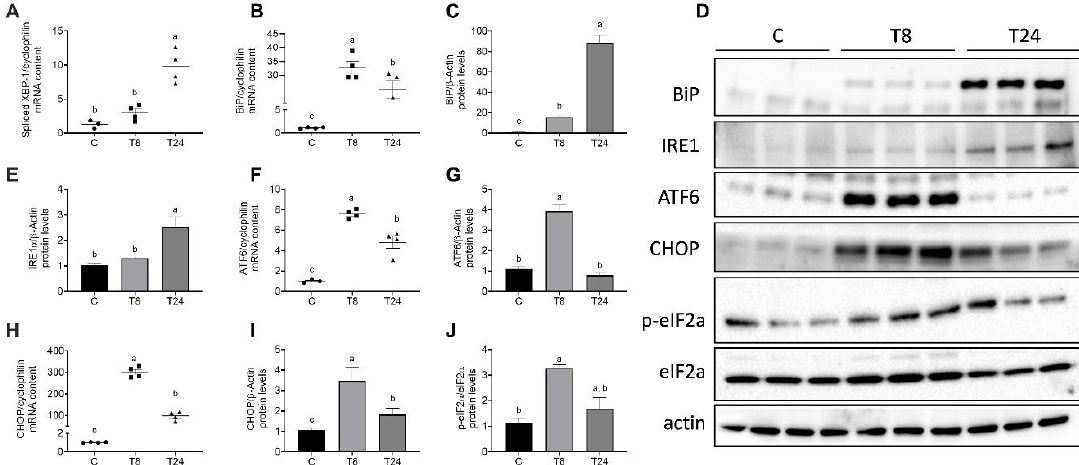
Figure 4. Activation of the unfolded protein response (UPR) in the kidney of mice treated with tunicamycin. Mice received a single i.p. injection of vehicle or tunicamycin (1 g/Kg body weight), and the kidney was obtained after 8 h (T8) or 24 h (T24). Spliced XBP-1 ( A ) and BiP mRNA content ( B ), densitometric analysis of BiP protein content ( C ), BiP, IRE-1, ATF6, CHOP and total and phosphorylated eIF2 α immunoblots ( D ), densitometric analysis of IRE-1 protein abundance ( E ), ATF6 mRNA ( F ) and protein abundance ( G ), CHOP mRNA ( H ) and protein abundance ( I ) and densitometric analysis of p-eIF2 α /eIF2 α , ( J ) Values are means ± SEM, n = 4–6. Means without a common letter differ significantly, a > b > c ( p <